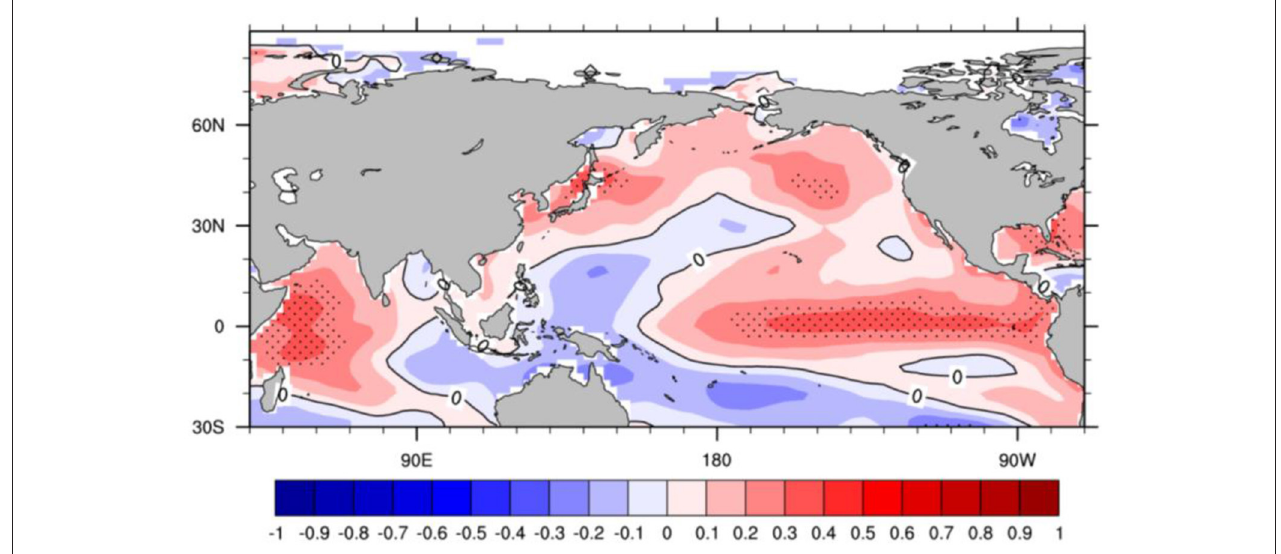
FIGURE 3 | Regression of global sea surface temperature (unit: ◦ C) in early winter against PC1 of TP snowfall in early winter (black dots indicate the values exceeding the 95% confidence level).